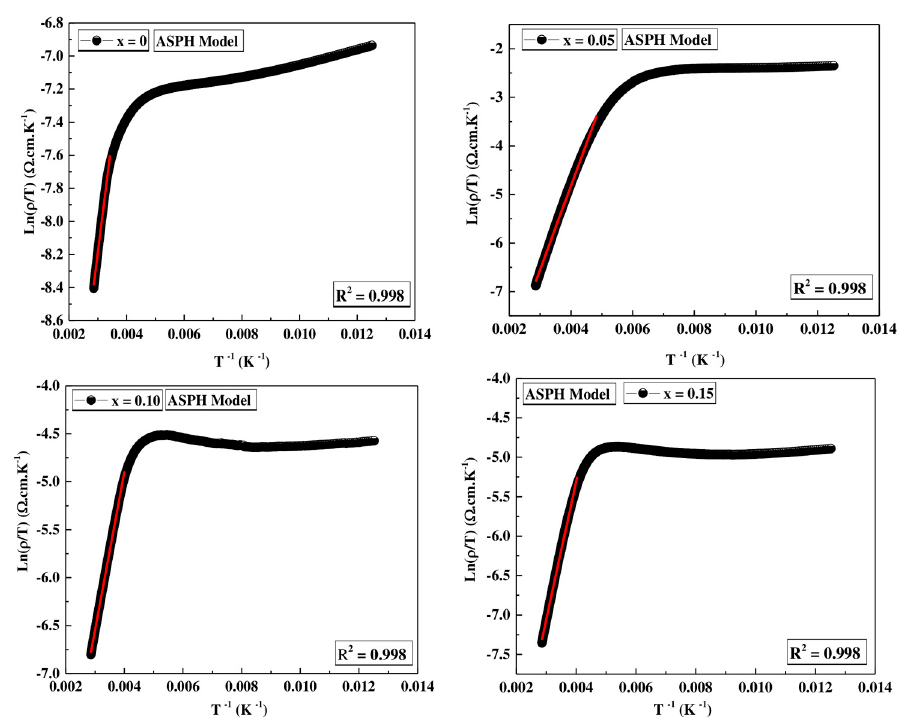
Figure 15. Plots of Ln ( ρ /T) vs. inverse temperature for Pr (cid:2868).(cid:2875) Sr (cid:2868).(cid:2871) Mn ((cid:2869)(cid:2879)(cid:2934)) Co (cid:2934) O (cid:2871) (0 ≤ x ≤ 0.15) com- pounds. The red solid line corresponds to fit by Equation